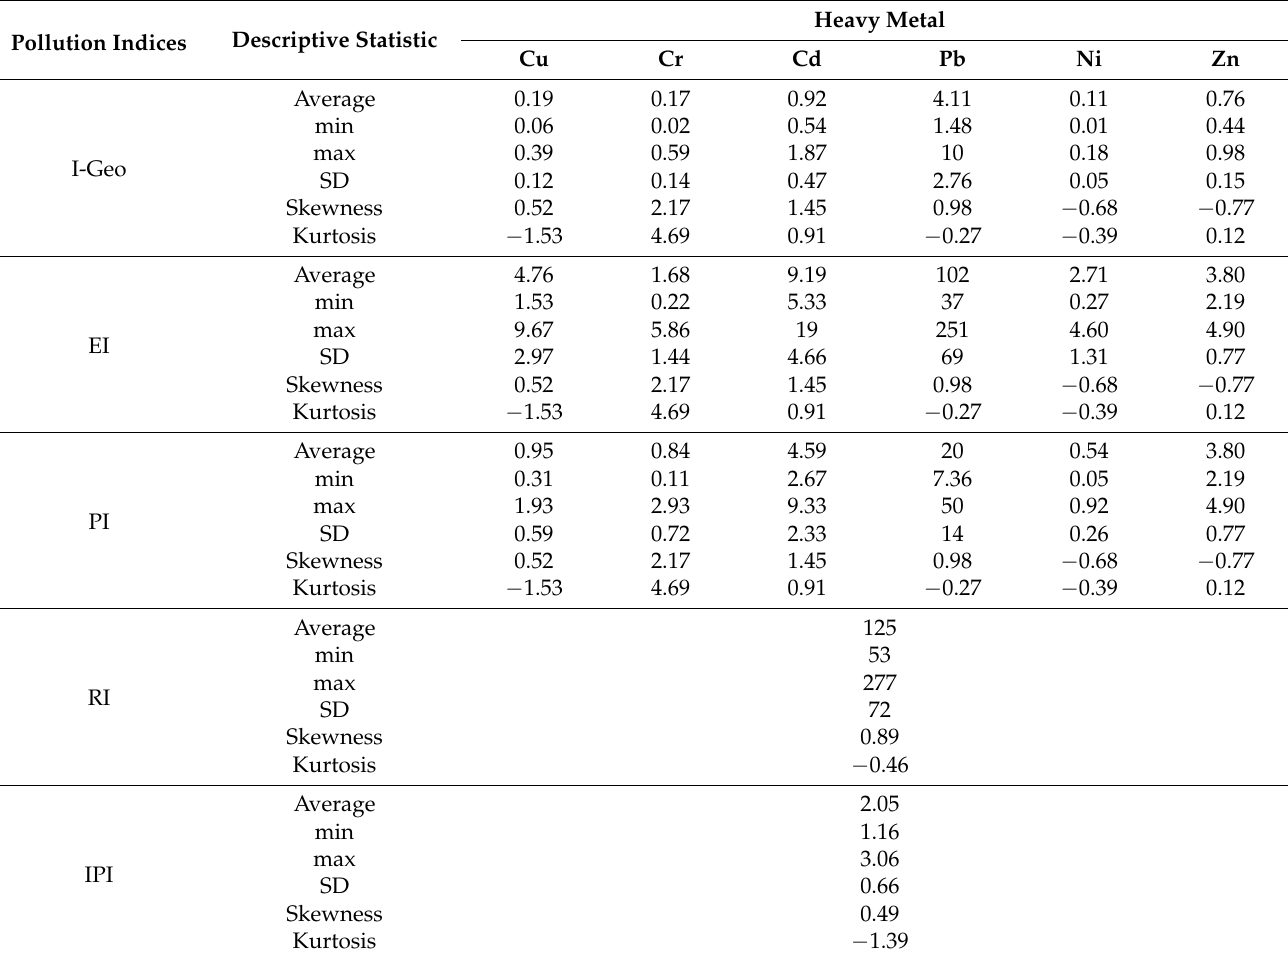
Table 2. Heavy metal pollution indices in